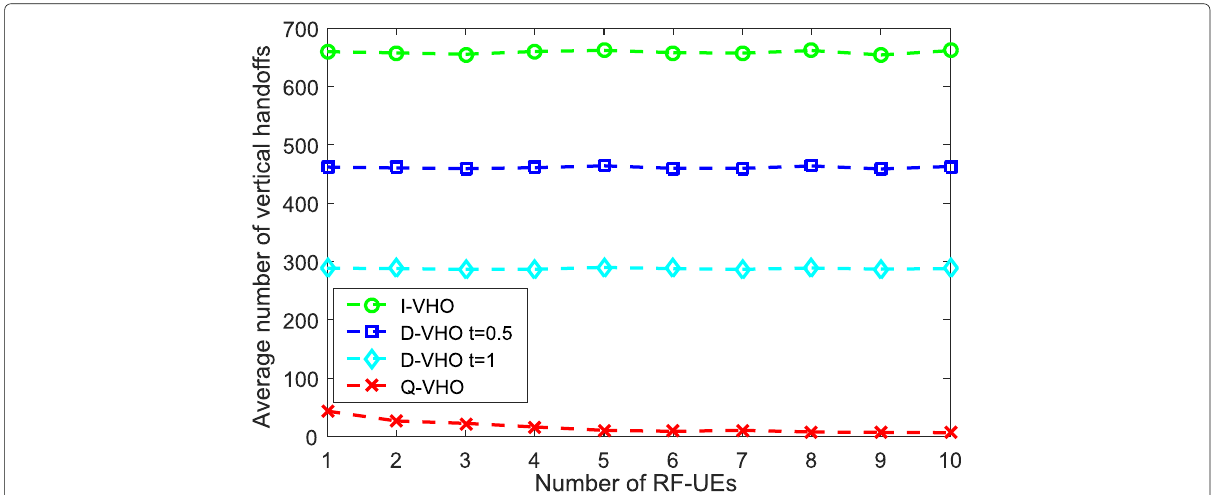
Fig. 5 The impact of the number of RF-UE on the average number of vertical